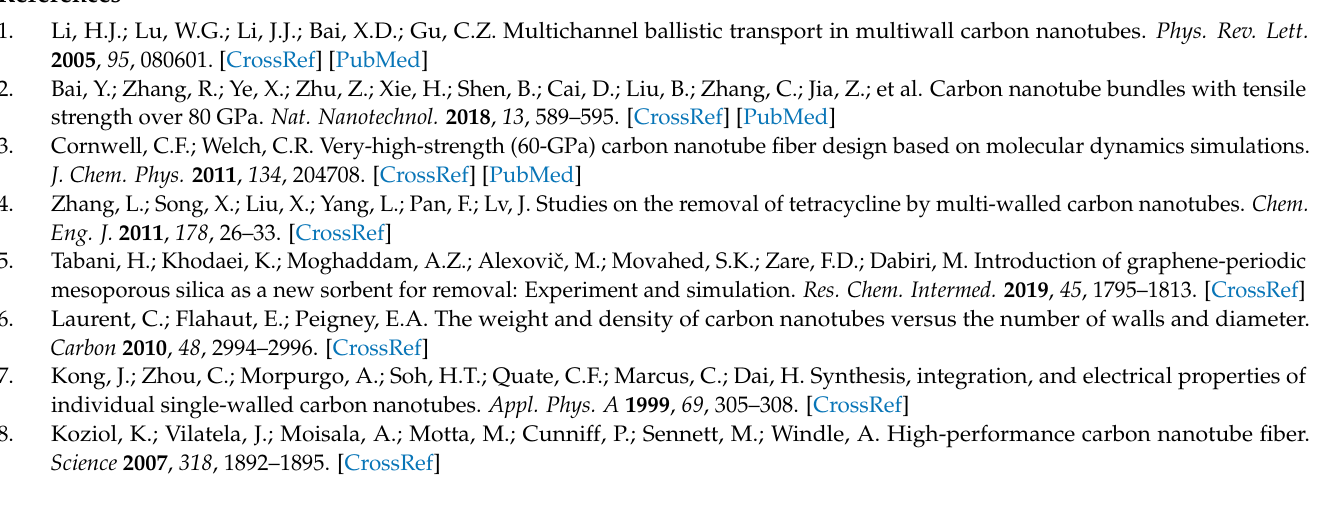
Figure S4: (a) Relationship between structural length and effective length. (b) Structural length dependences of electrical conductivity; Figure S5: (a) Photograph of custom-made fiber diameter measurement system including high-speed optical micrometer (LS-9006MR series, Keyence). (b) Schematic illustration of how to measure yarn diameter. (c) Cross-sectional SEM image of Table S1: Carbonaceous content of CNT yarns estimated by